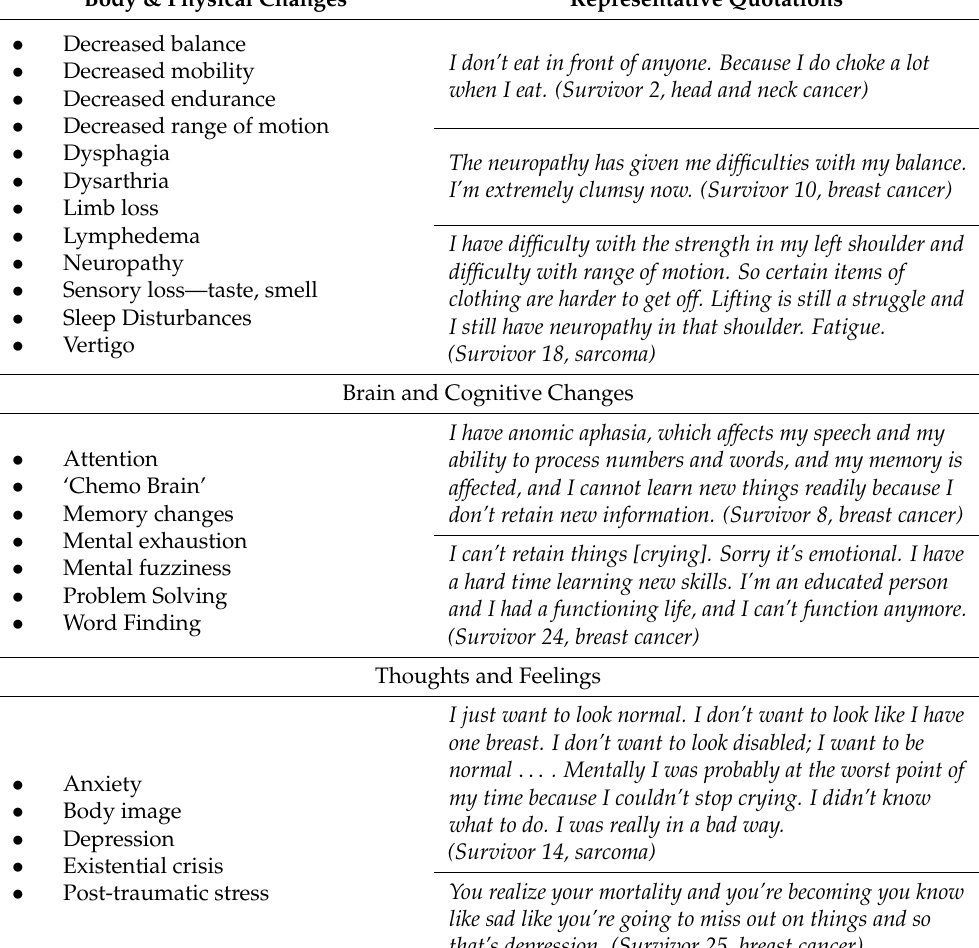
Table 2. Participant-identified long-term effects with representative